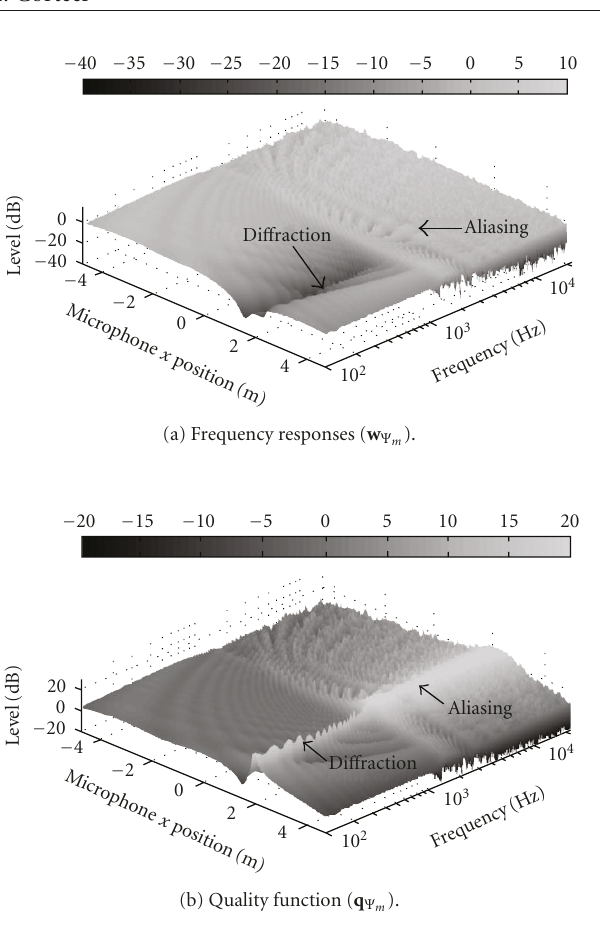
Figure 5: Frequency responses ( w Ψ ) and quality function ( q Ψ ) m m of an 8m, 48-channel, loudspeaker array simulated on a line at 2m from the loudspeaker array for synthesis of a source of degree +2 (close source of Figure